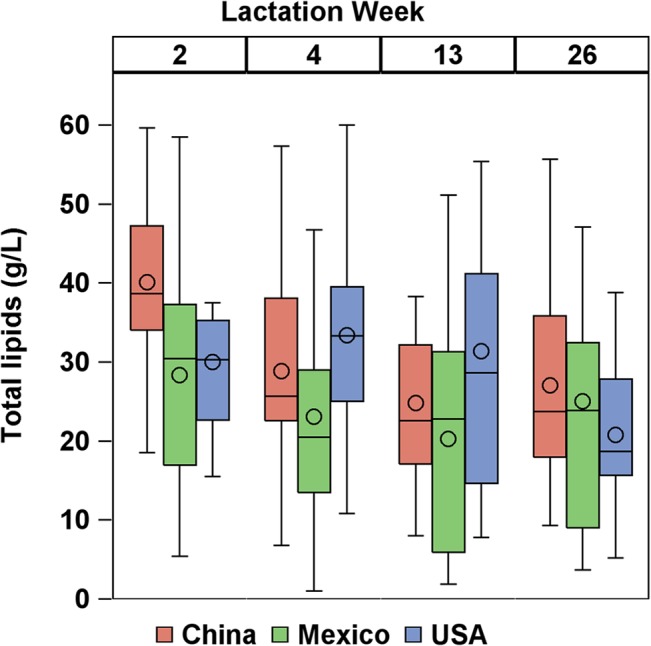
Total lipid content (g/L) by country and lactation stage.Boxes represent 25th, 50th, and 75th percentiles. Circle represent mean. Whiskers represent either minimum/maximum or 25th/75th minus/plus 1.5 x interquartile range, whichever is closer to the median.